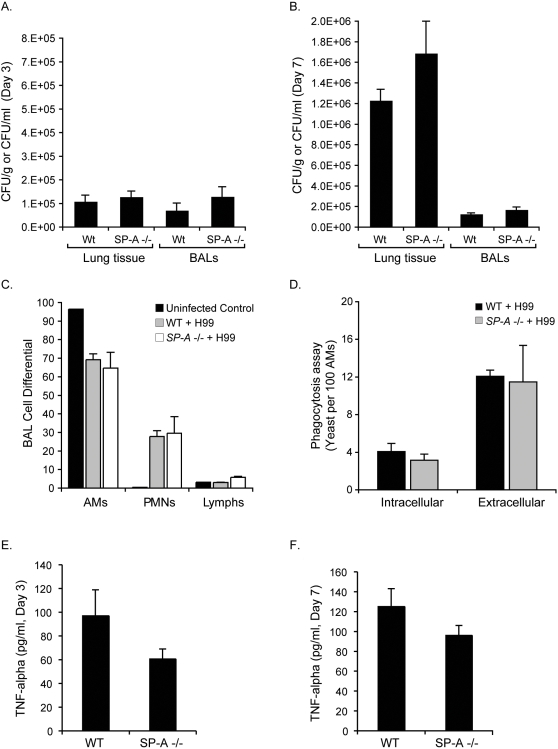

C. neoformans infection appears to progress equivalently in SP-A-/- and wild-type mice.(A.) Three days post infection the fungal burdens of lung tissue and BALs from wild-type (n = 4 and n = 7, respectively) and SP-A-/- (n = 3 and n = 8, respectively) mice were equivalent. (B.) A similar trend was observed at day seven post infection; no difference between groups were observed. (C.) Quantitative differentials showed no differences in the numbers of macrophages, polymorphonuclear neutrophils or lymphocytes present in BALs collected from wild-type (n = 3) and SP-A-/- (n = 3) mice seven days post infection. (D.) There were also no differences in the numbers of macrophages from SP-A-/- (n = 3) and wild-type mice (n = 3) that had phagocytosed C. neoformans. TNFα levels (measured by ELISA) in the lungs of wild-type and SP-A-/- mice at day three (n = 8 and n = 7, respectively) and seven (n = 16 and n = 17, respectively) post infection were equivalent (P>0.05). Results represent the mean plus or minus the standard error of the mean for the indicated number of experiments. (AM, alveolar macrophage; PMN, polymorphonuclear neutrophils; Lymphs, lymphocytes; BAL, bronchoalveolar fluid)